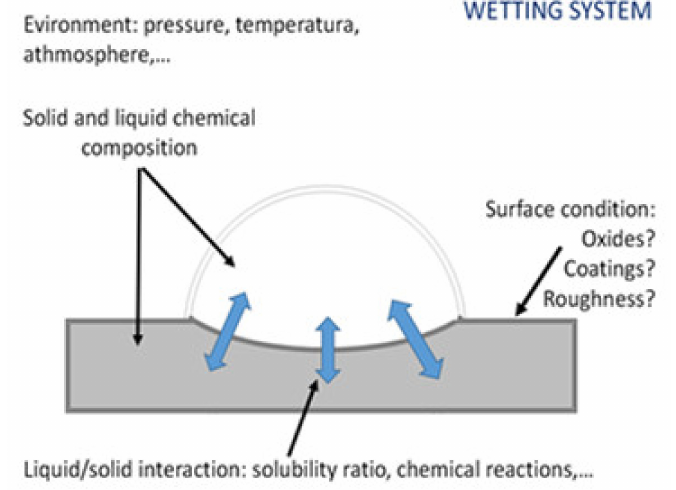
Figure 7. Wetting system that shows the main controlling agents of this process [53].